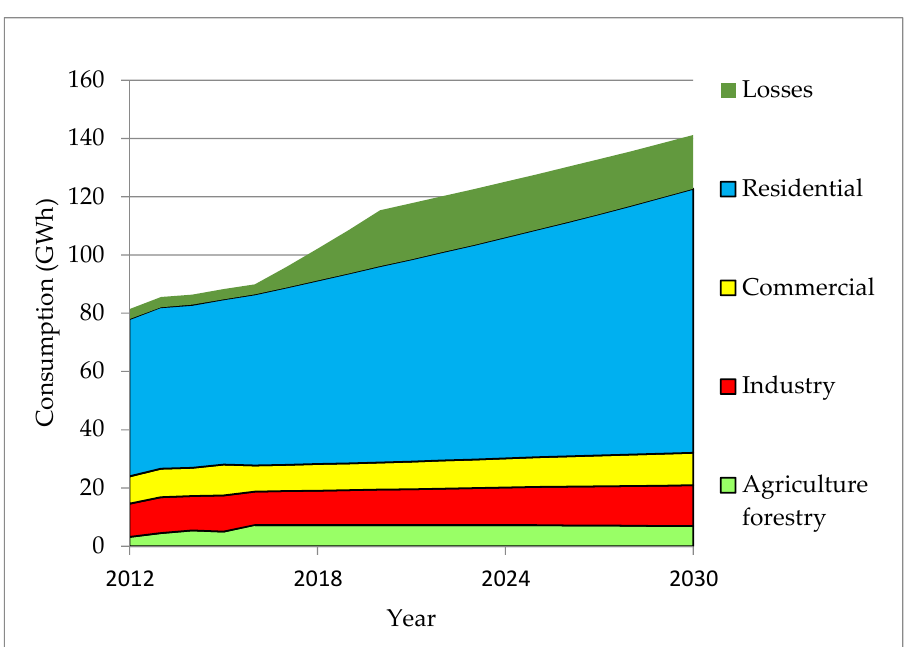
Figure 15. Electricity consumption of Isla de la Juventud in 2030 in the RENES scenario. Source: own elaboration with the model [27].